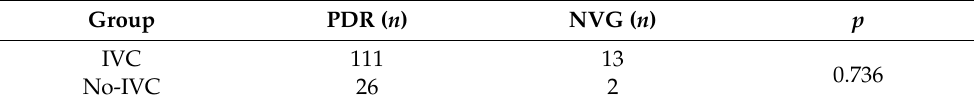
Table 7. NVG at 2 years after surgery between two groups.